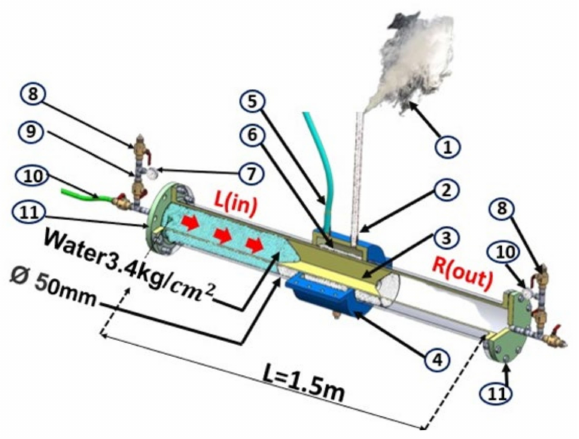
Figure 1. Detailed ice plug freezing mobile module.